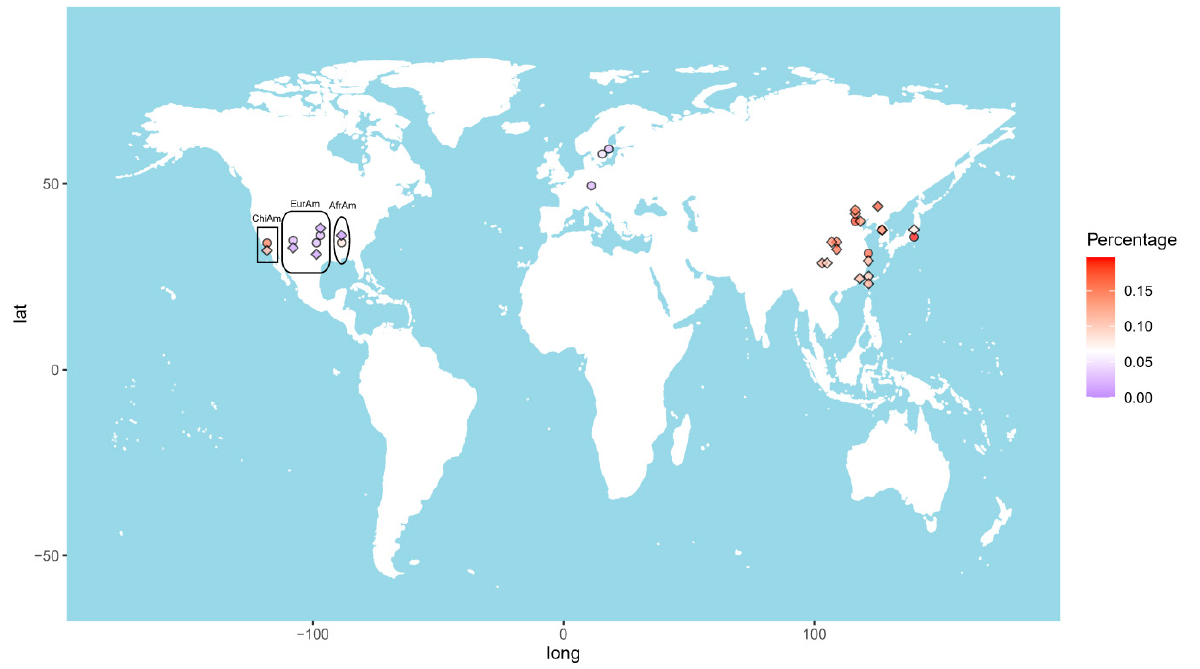
Figure 1. Heat map of the allele frequencies of the GTF2I rs117026326 (diamond) and the NCF1 rs201802880 (circle) across the world. Each color dot represents frequency of the GTF2I rs117026326 or the NCF1 rs201802880 in a single population. ChiAm: Chinese American; EurAm: European American; AfrAm: African American.